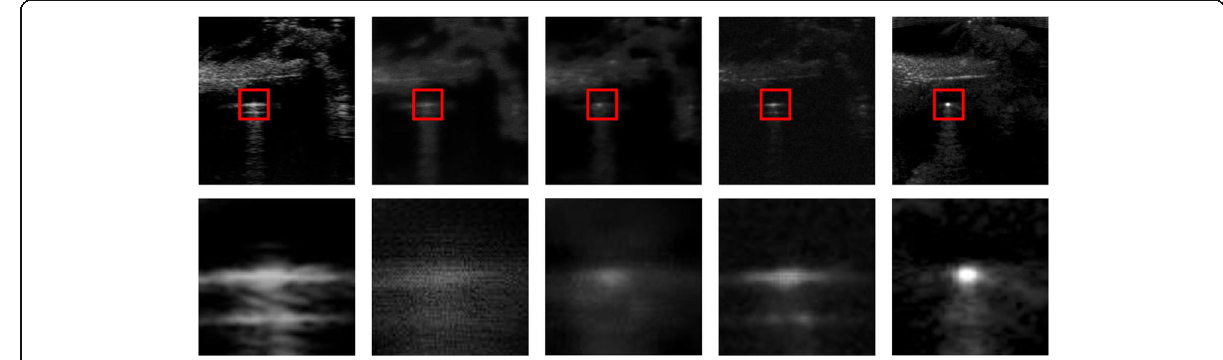
Fig. 7 Result examples of pork phantom images. On the first line from left to right are low-quality image, encoder-decoder result, U-Net result, SSC U-Net result, and high-quality image correspondingly. The second line shows the image in the corresponding red box in the first